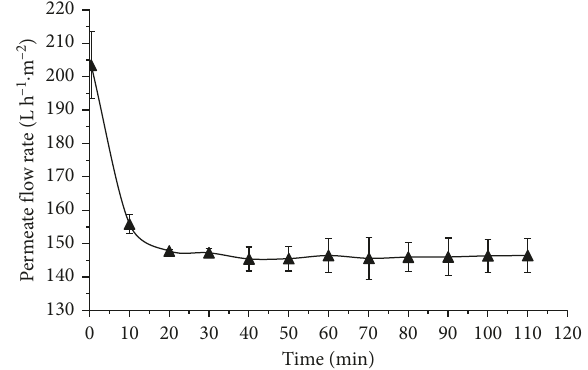
Figure 4: Permeation flux of the wastewater obtained at 1.4bar for the MF membrane (volumetric flow of 0.5 L